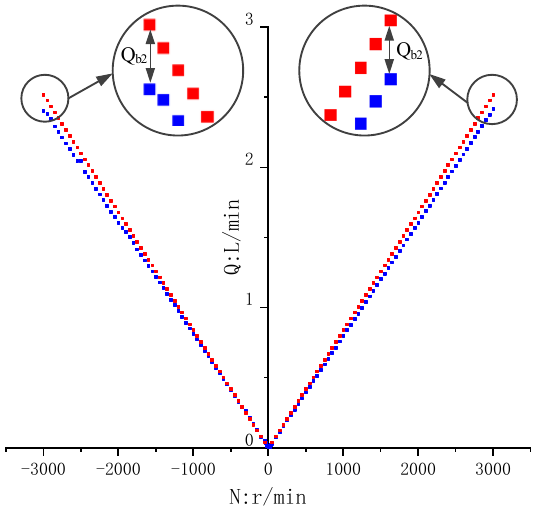
Figure 7. No-load flow characteristics of positive displacement pump.